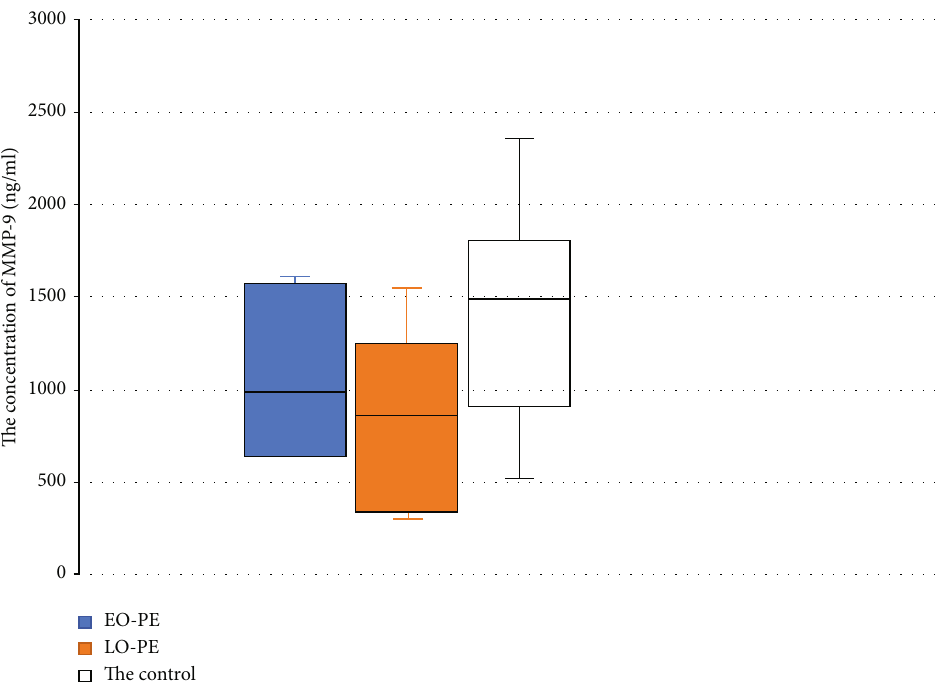
Figure 4: Comparison of the level of MMP-9 in the subgroups of EO-PE and LO-PE with the control group. Box plot showing the median (bold horizontal line), interquartile range (box), and total range